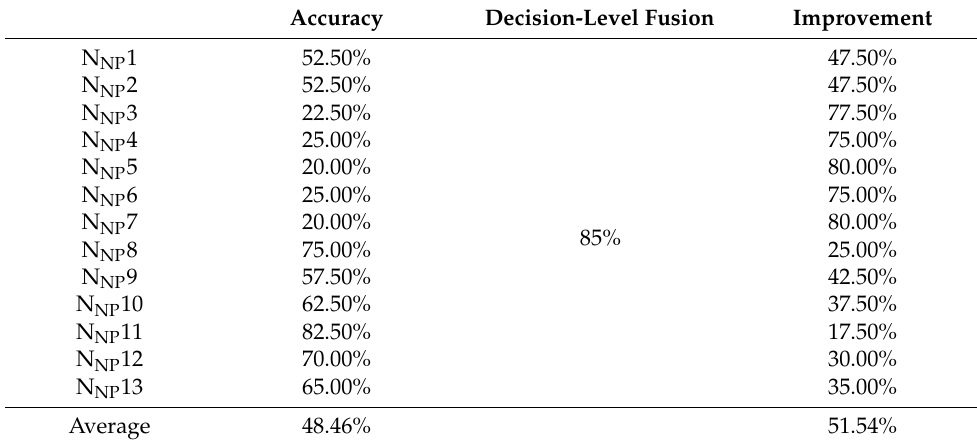
Figure 15. Detection results of the testing samples using the 13 networks. Table 6. Comparisons of the detection results before and after the decision-level